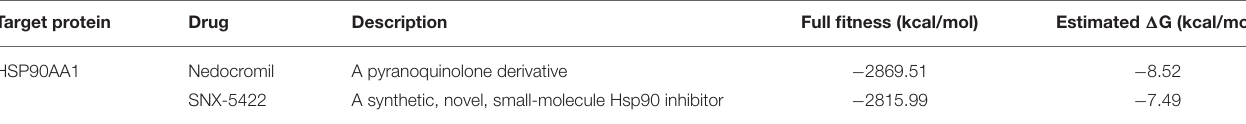
TABLE 5 | Protein–drug interactions and their binding affinity by molecular docking